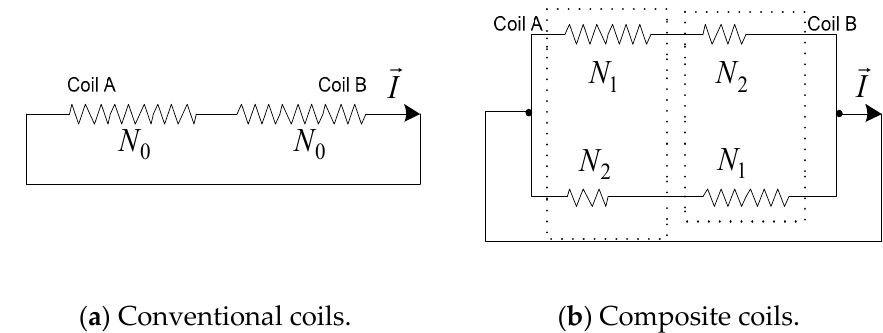
Figure 2. A rotor winding branch composed separately of common coils and composite coils.